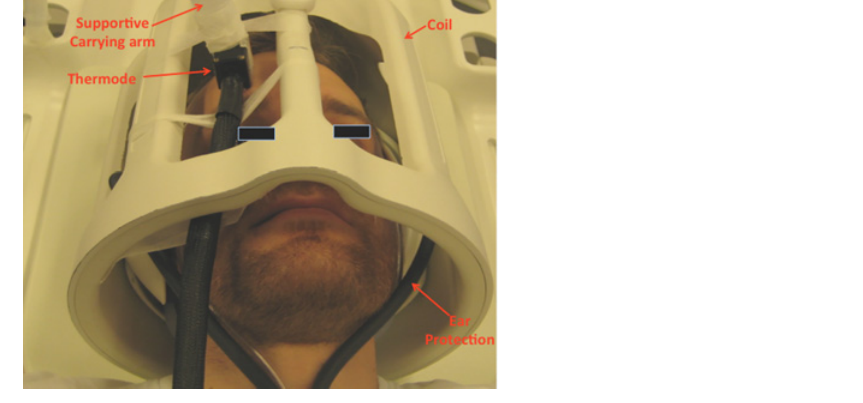
Fig 2. Study Setup: Reconstruction of the study setup. The subjects would be placed in the supine position inside the MRI scanner. The upper boarder of the eyebrows was used to centralize the subjects position in the scanner. The thermode was fitted in between the bars of the coil and then attached to the V1 area of the forehead. A custom build MRI compatible carrying arm and adhesive tape was used to ensure that only the heating element of the thermode came in contact with the skin. The subjects would be wearing ear protection under the whole duration of the MRI scans.